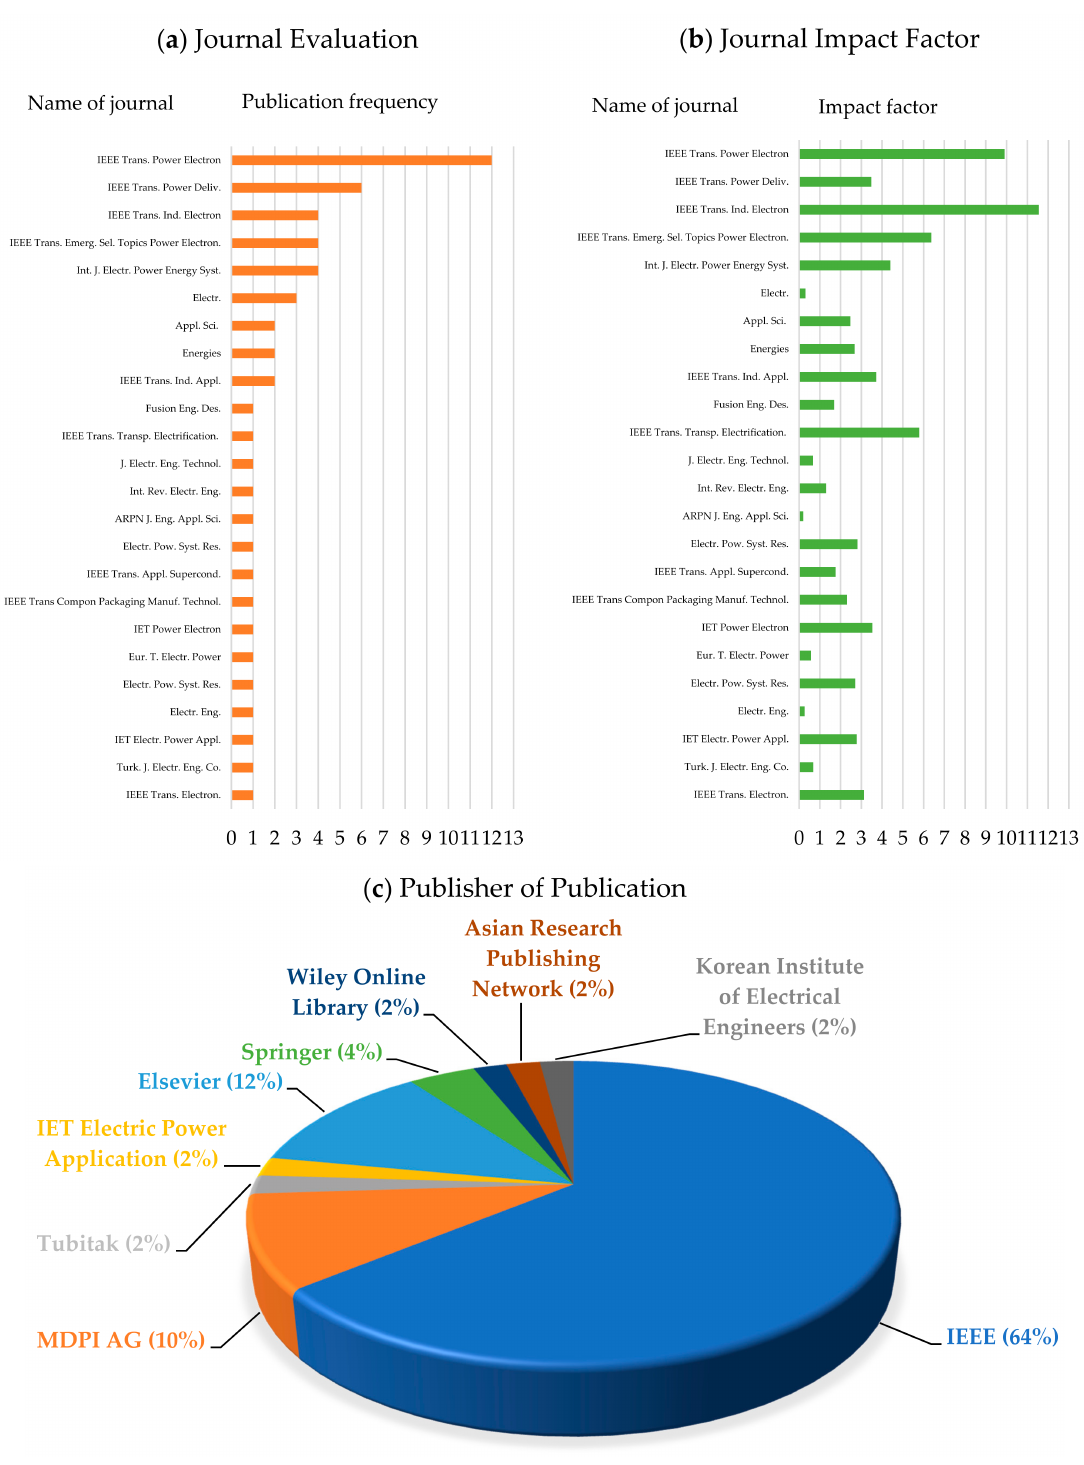
Figure 6. Papers for ( a ) Journal evaluation, ( b ) Journal of impact factor, and ( c ) publisher of the